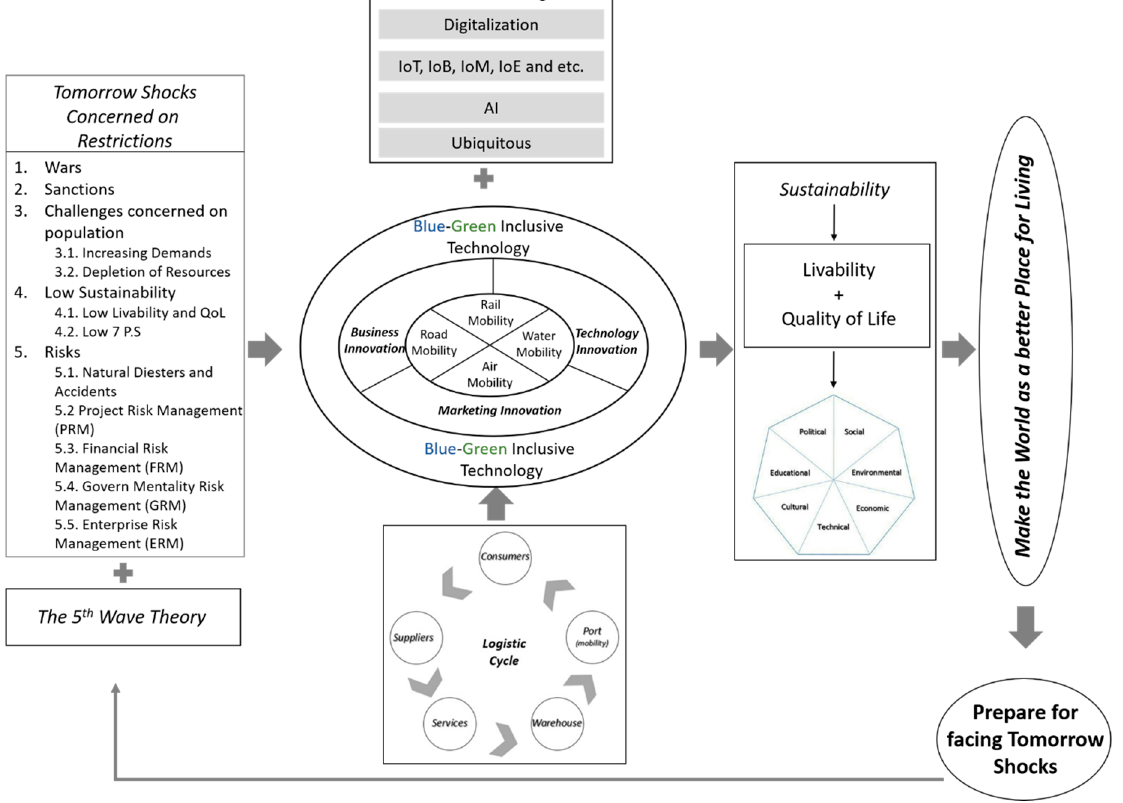
Figure 13. Technologies for making the World a Better Place for Living.